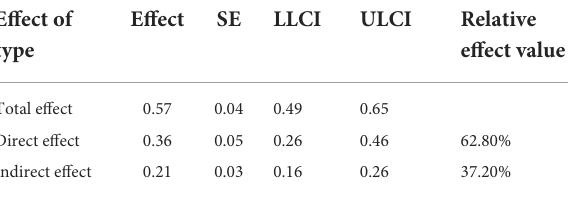
TABLE 5 Mediation effect Bootstrap